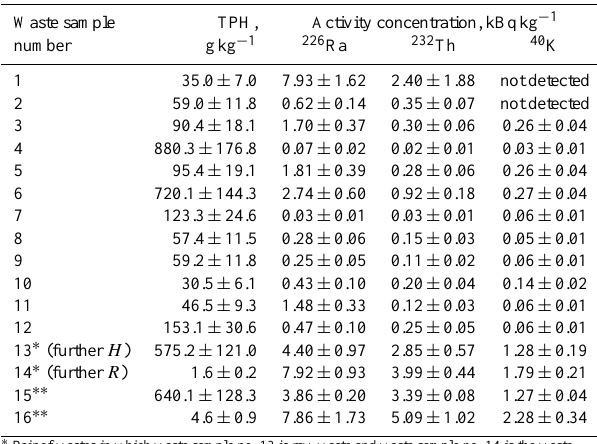
Table 1. Chemical properties of the oil wastes from the Tik- chonovskii petroleum production